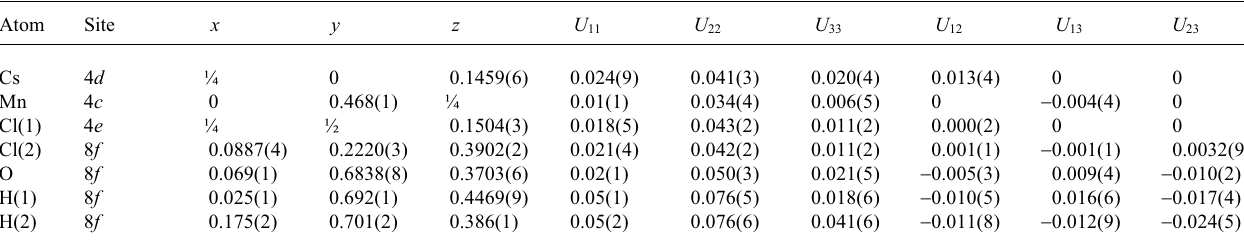
Table 2. Atomic coordinates and displacement parameters (in Å 2 )